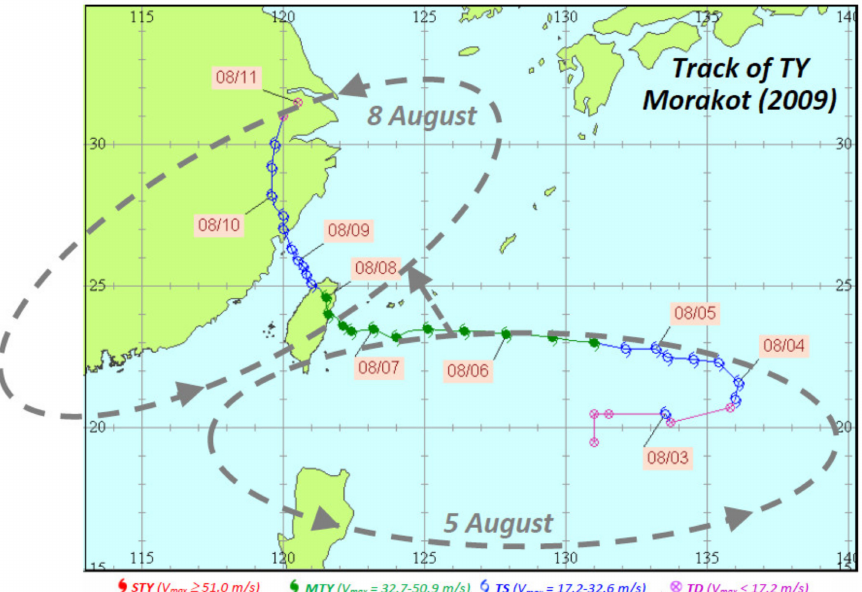
Figure 2. Central Weather Bureau (CWB) best track (every 6 h) of TY Morakot (2009), overlaid with a schematic showing the approximate location and propagation of the background cyclonic monsoon gyre (at frequencies of 10–30 day) from 5 to 8 August (dashed gray) based on Hong et al. [52]. Different colors represent typhoon intensities of tropical depression (TD, <17.2 m s − 1 , purple), tropical storm or mild typhoon (TS, 17.2–32.6 m s − 1 , blue), moderate typhoon (MTY, 32.7–50.9 m s − 1 , green), and severe typhoon (STY, ≥ 51.0 m s − 1 , red). The month and date at 0000 UTC are labeled in “mm/dd” format. The original plot was produced and provided by the